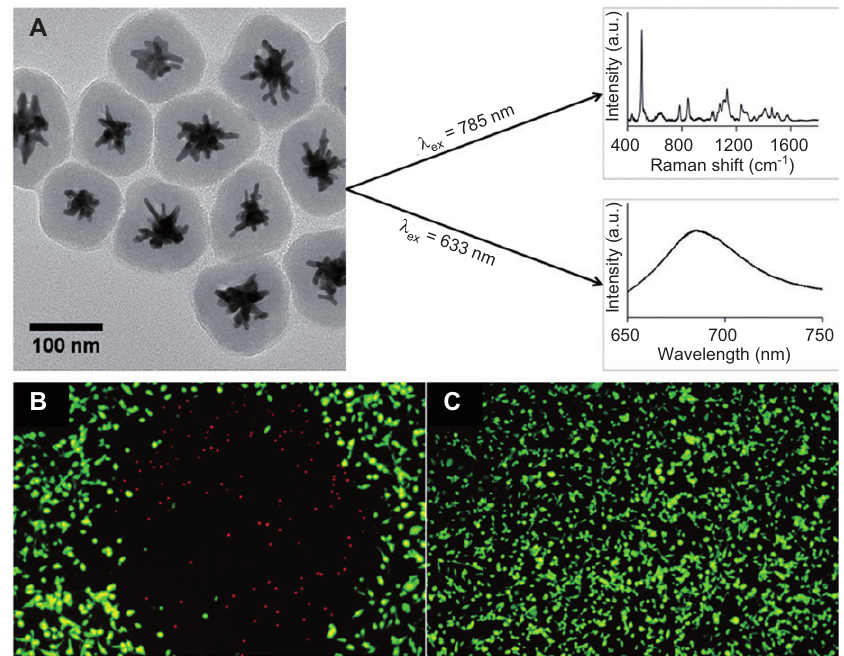
Figure 16 (A) TEM microscopy of MB silica-coated nanostars; MB SERS spectrum was collected at 785-nm excitation and MB fluorescence collected at 633-nm excitation. Fluorescence images of BT549 cells incubated with (B) MB silica-coated nanostar and (C) silica-coated nanostar without MB after 1 h of 633-nm laser irradiation. The green spots indicate live cells. Reproduced with permission from: Fales et al. (2011) . Copyright 2011, American Chemical